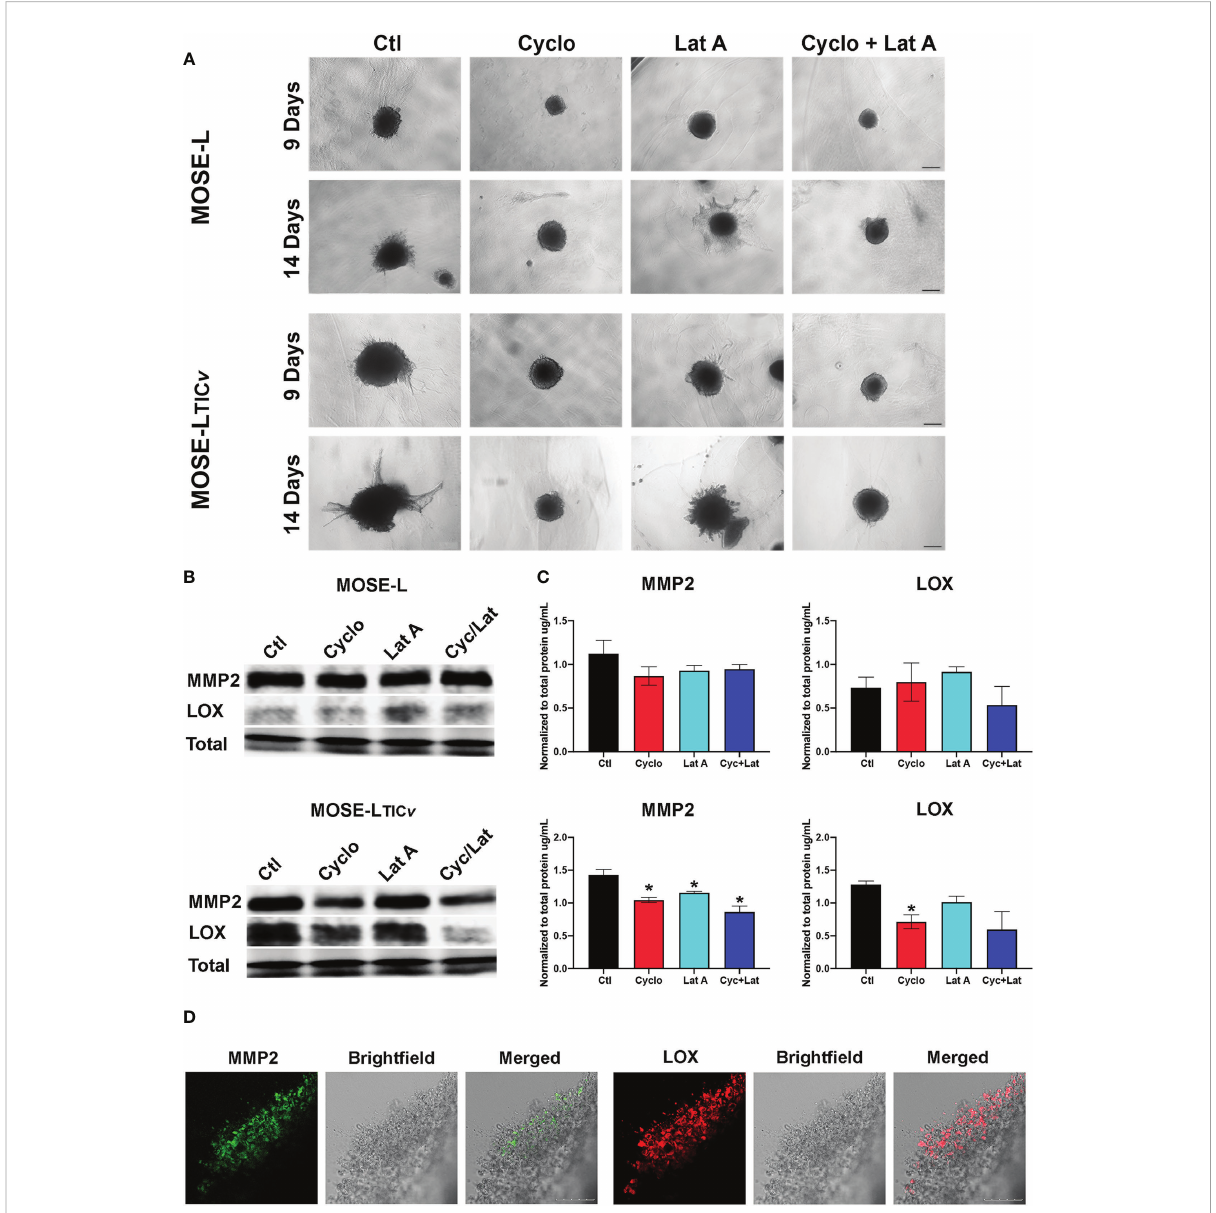
FIGURE 8 Inhibition of protein synthesis limits invasion through decreased MMP and LOX expression. (A) Spheroids embedded in collagen gels were treated with Cycloheximide (cyclo), Latrunculin A (Lat A), or a combination for 9 and 14 days. (B, C) Western blot analysis of MMP2 and LOX proteins in 24 h drug-treated adherent spheroids; *p<0.05 compared to the untreated control. (D) Embedded MOSE-L TIC v spheroids after 9 days were immunostained for MMP2 and LOX antibodies. Scale bar set at